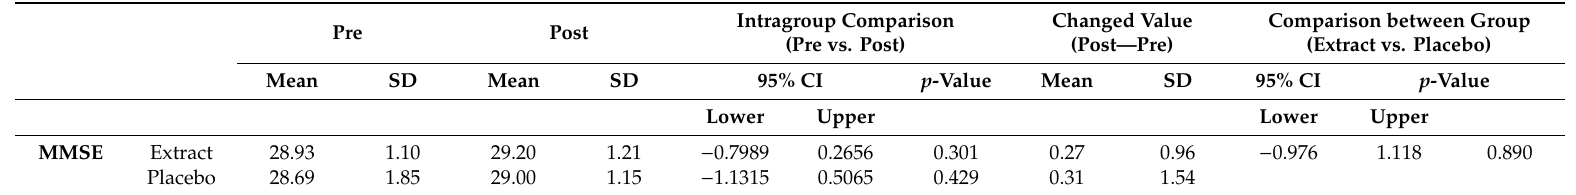
Table 3. Changes in the Mini Mental State Examination (MMSE) between ES extract plus DR extract intake and placebo intake.